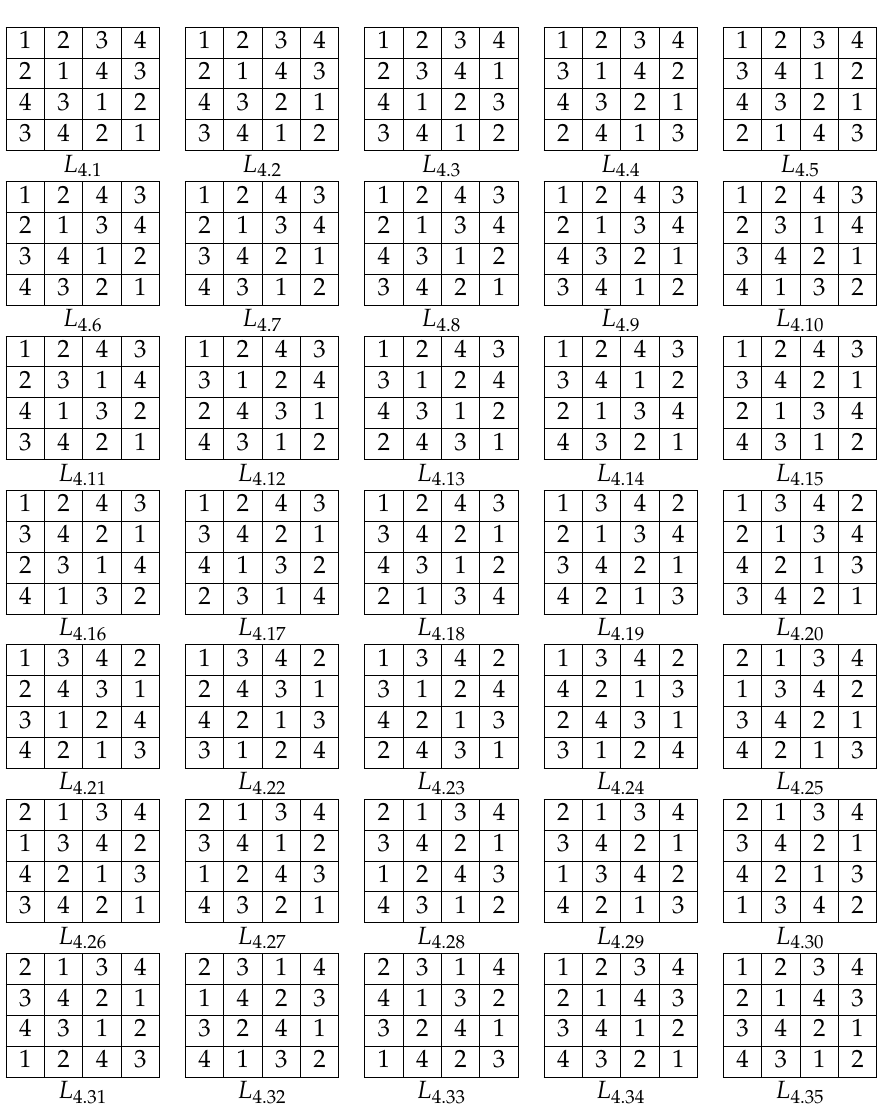
Figure 1. Isomorphism classes of Latin squares of order